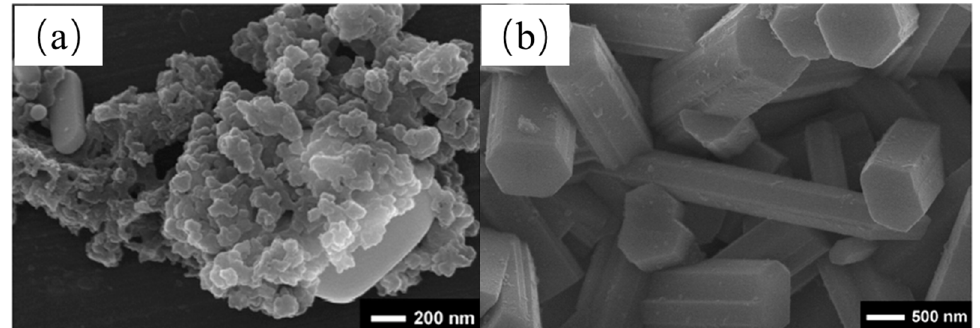
Figure 8. FESEM images of precursor derived from the nascent state gel calcined at ( a ) 1300 °C and ( b ) 1550 °C for 2 h, respectively. [79].